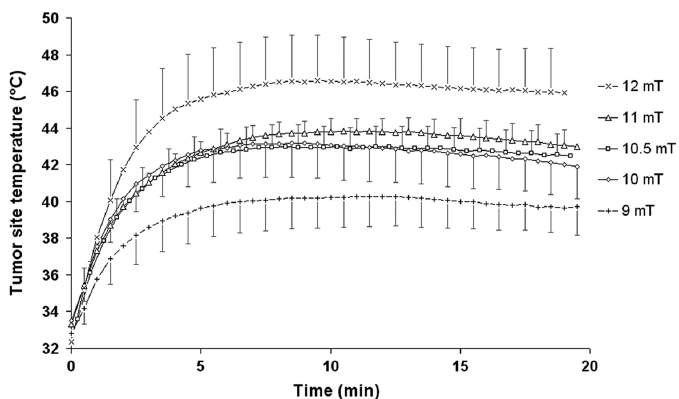
Figure 15. Thermogram of mean intratumoral tumor temperature as a function of treatment time and magnetic field strength. Reprinted with permission [64]. Copyright 2021, Taylor & Francis.